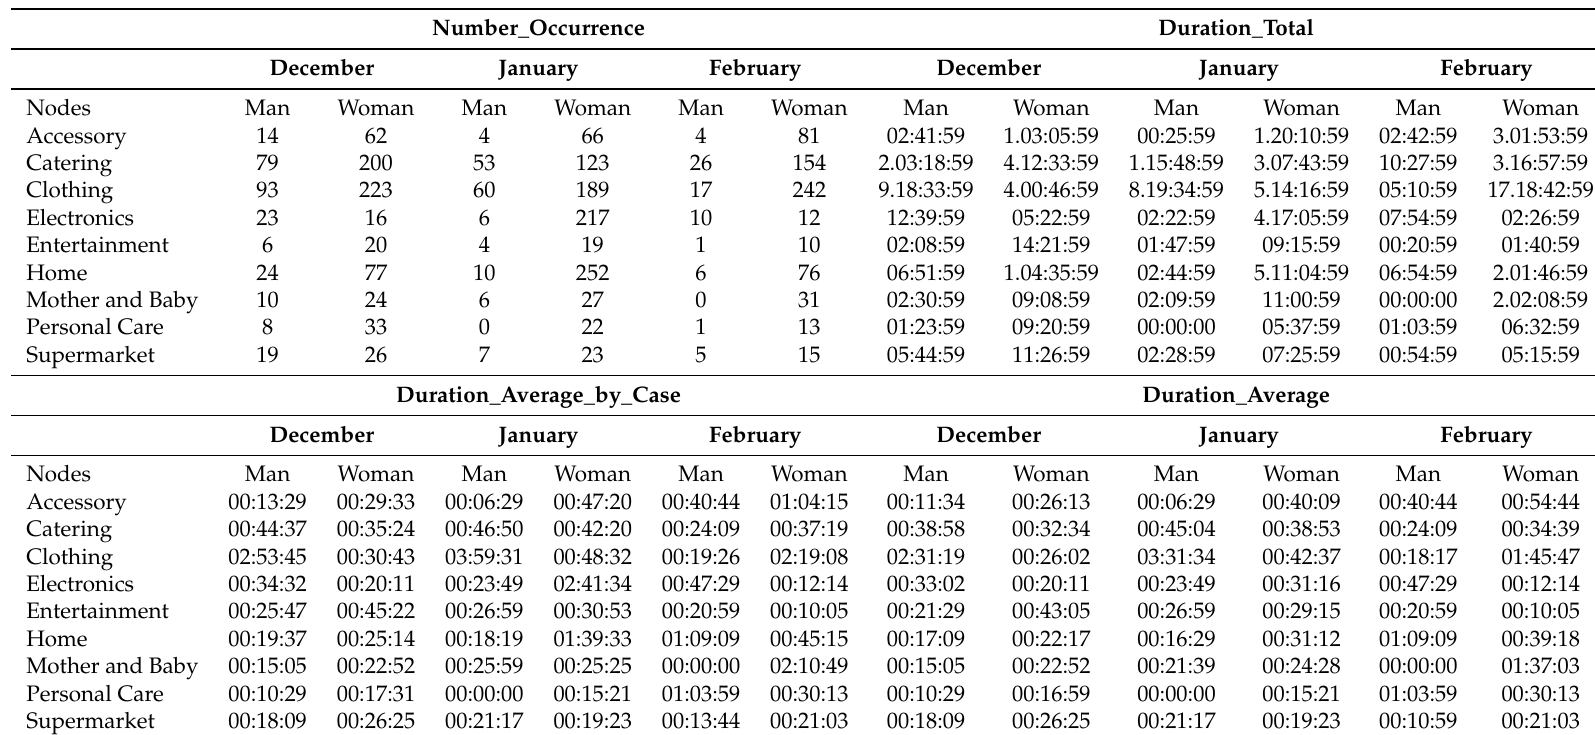
Table 6. All data